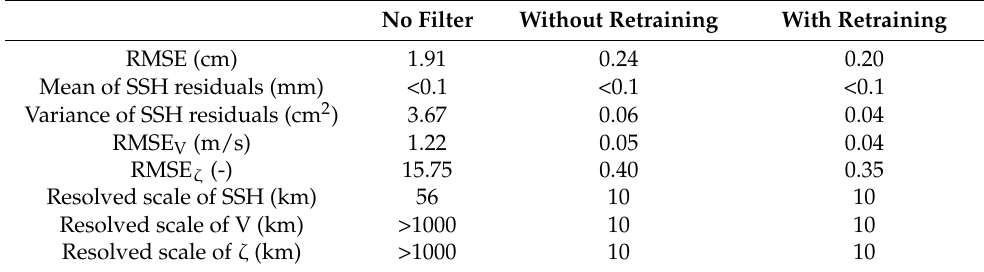
Table A1. Offshore (>10 km to the coast) scores with and without retraining for the scenario with 50% more